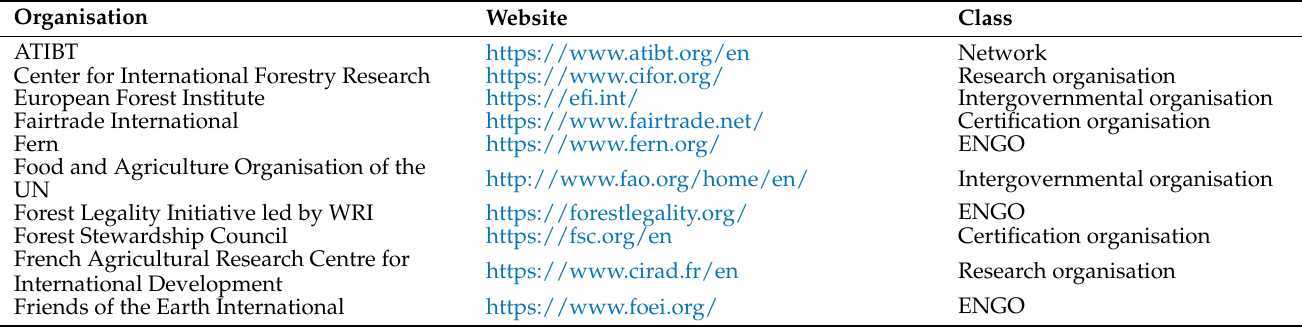
Table 3. Organisational websites that will be